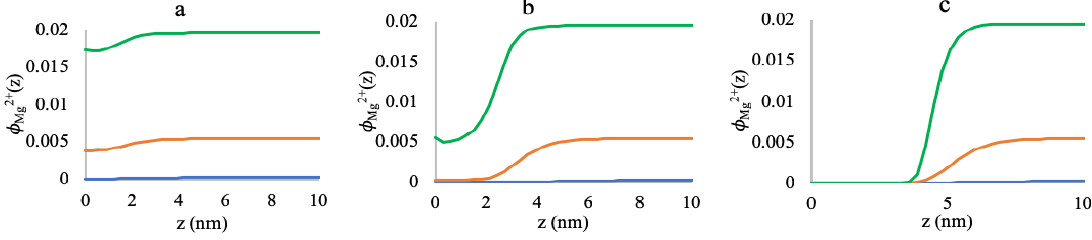
Figure 5. Free Mg 2 + volume fraction profiles as a function of distance from the grafting surface at ( a ) 0.005 chains/nm 2 , ( b ) 0.05 chains/nm 2 , and ( c ) 0.5 chains/nm 2 grafting densities for 3 mM (blue lines), 50 mM (Yellow lines), and 180 mM (green lines) MgCl 2